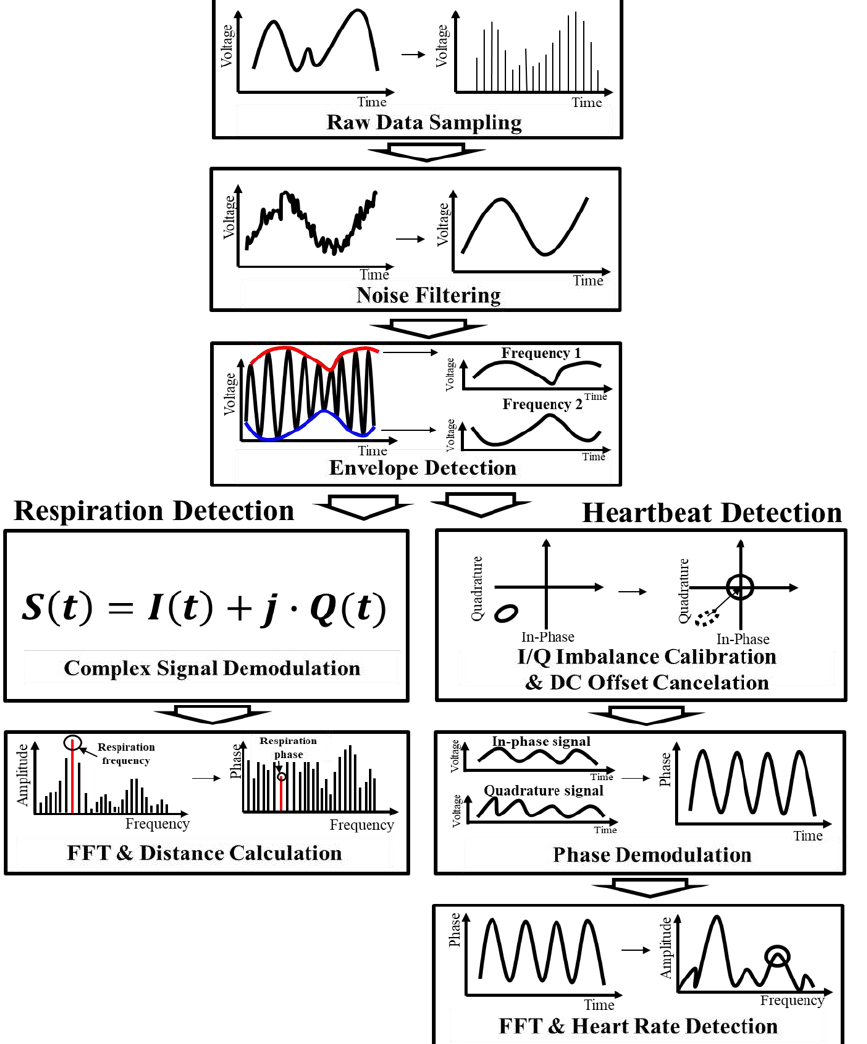
Figure 6. Signal processing procedure in the proposed vital-signs detector.